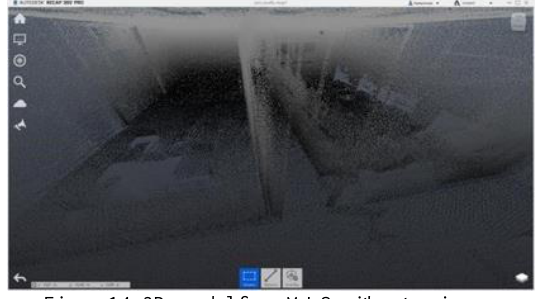
Figure 14: 3D model from MLS without an image.